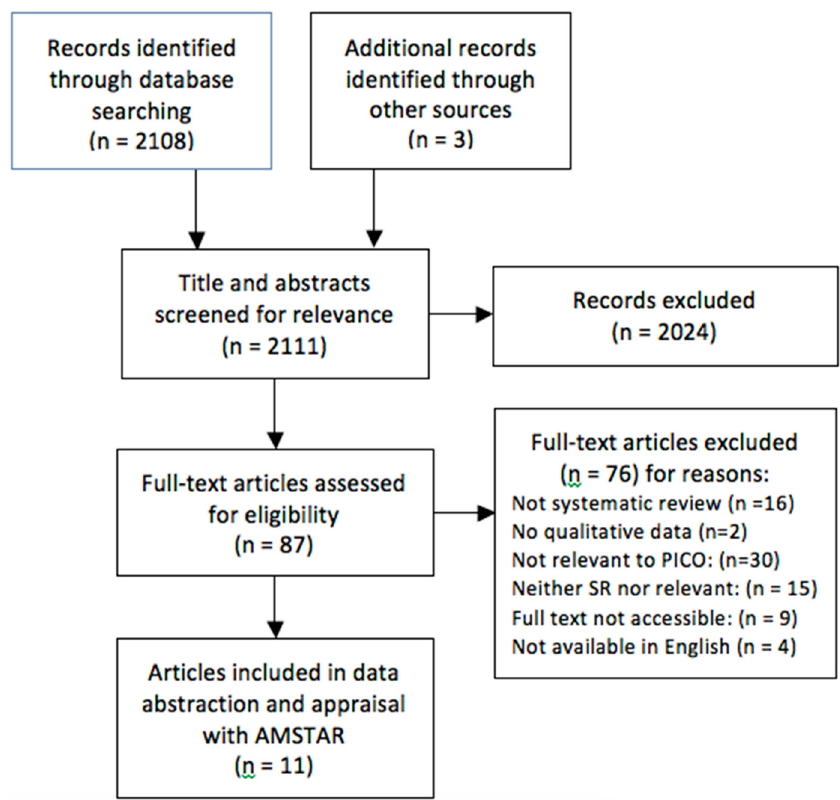
Figure 1. PRISMA Flow Diagram.